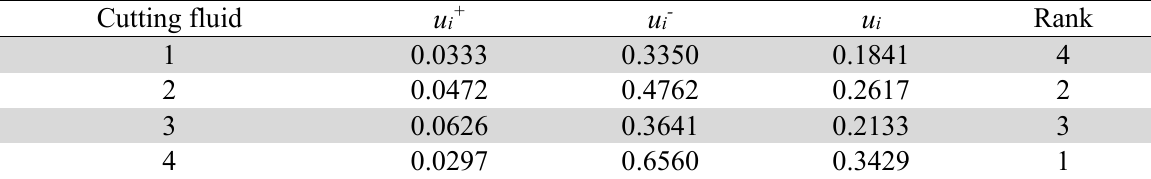
Computational details of the ROV method for case study